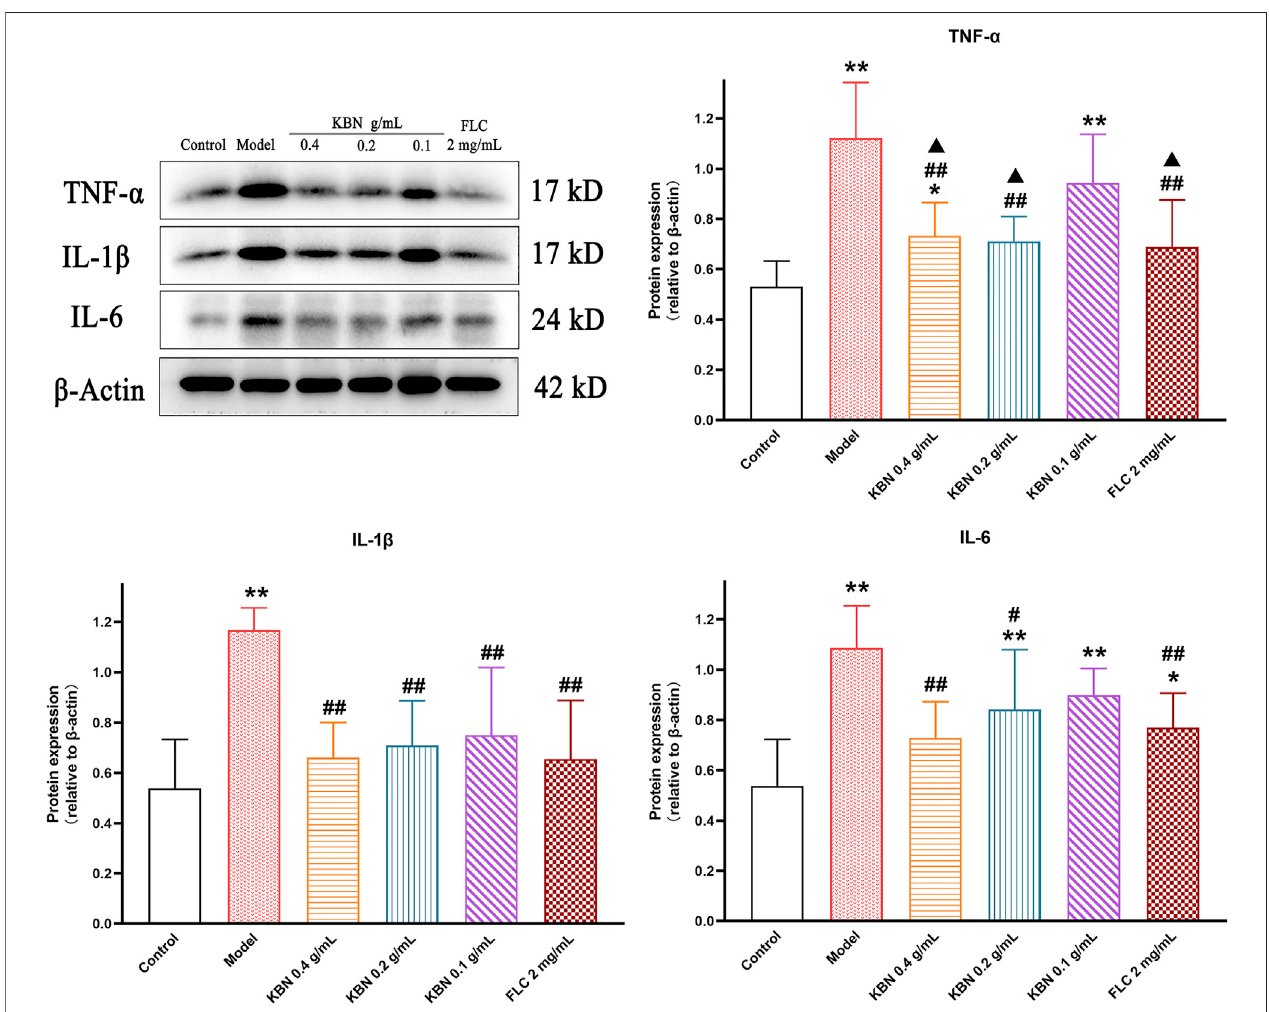
FIGURE 9 | Effect of KBN on the protein expression of TNF- α , IL-1 β , and IL-6 in the vaginal tissues. N (cid:1) 6. Each value is presented as the mean ± SD. * p < 0.05, ** p < 0.01 versus the control group; # p < 0.05, ## p < 0.01 versus the model group; ▲ p < 0.05 versus the KBN 0.1 g/mL group.